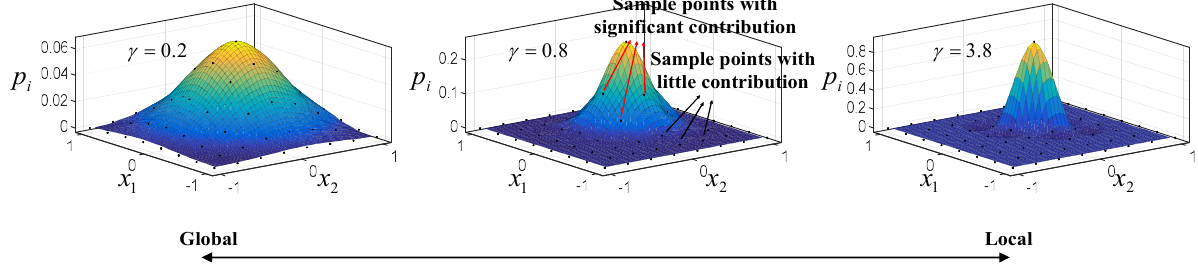
Figure 1. The basis functions with different γ in a two − dimensional convex